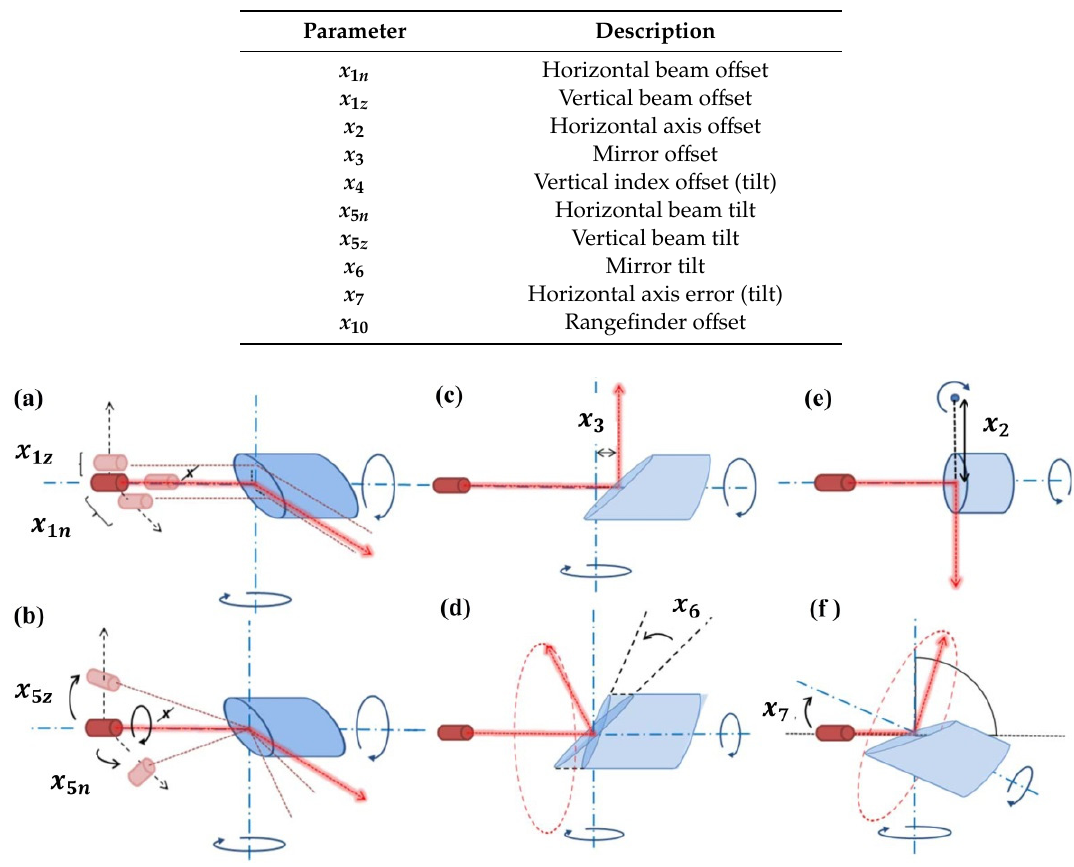
Figure 2. Mechanical misalignments of panoramic TLSs, ( a ), ( b ) – laser offsets and tilts, ( c ), ( d ) – o ff set and tilt, ( e , f )—horizontal axis o ff set and tilt mirror offset and tilt, ( e ), ( f ) – horizontal axis offset and tilt [23]. Table 1. The list of mechanical misalignments relevant for high-end TLSs.